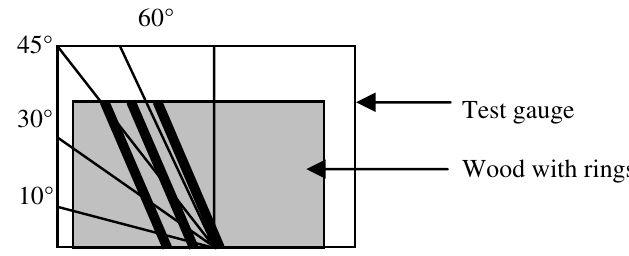
Fig. 2. Checking the orientation of rings according to EN 117 [4] standard.